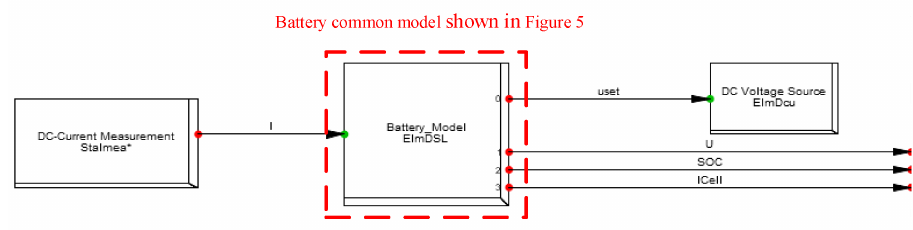
Figure 4. Composite model of the battery.